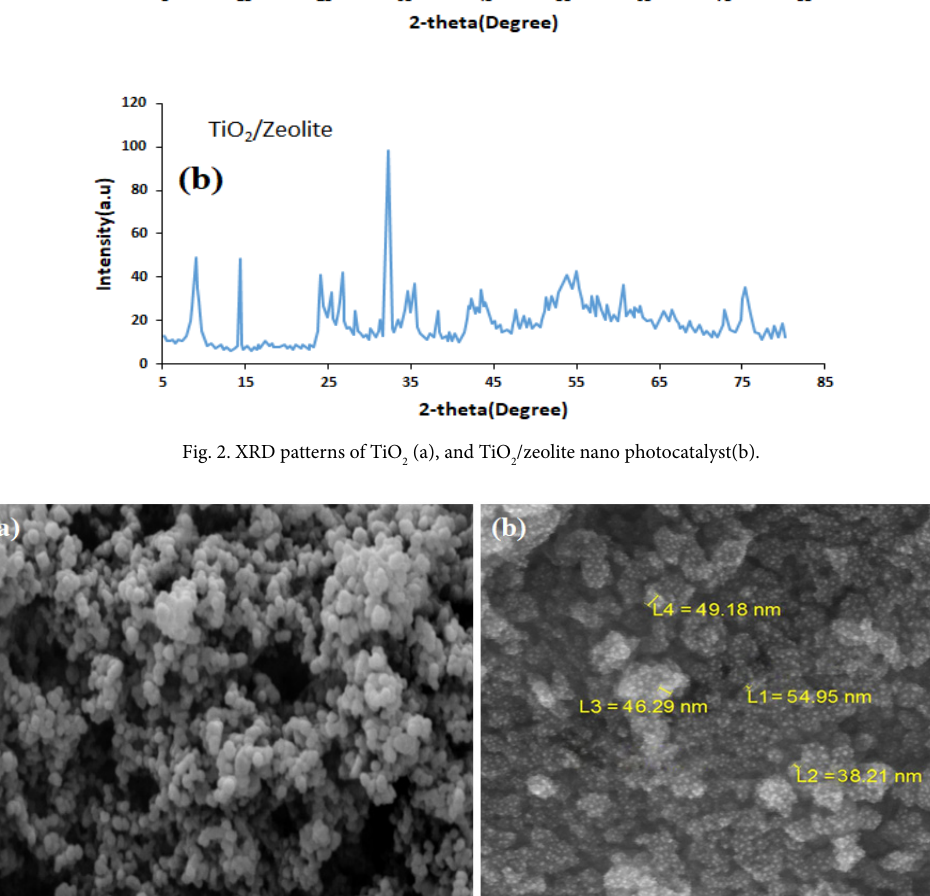
and (b) TiO /zeolite nano 2 2